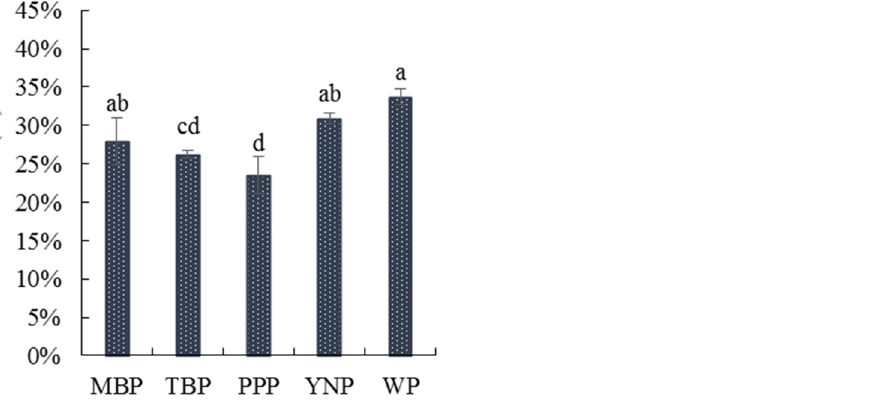
Figure 3. The cooking losses of the five types of pork. Values are shown as the mean ± standard deviation. Different letters above the bars of standard deviations indicate significant differences ( p < 0.05); MBP, manor black pigs; TBP, Tibetan black pigs; PPP, Pipa pigs; YNP, Yihao native pigs; WP, white pigs.